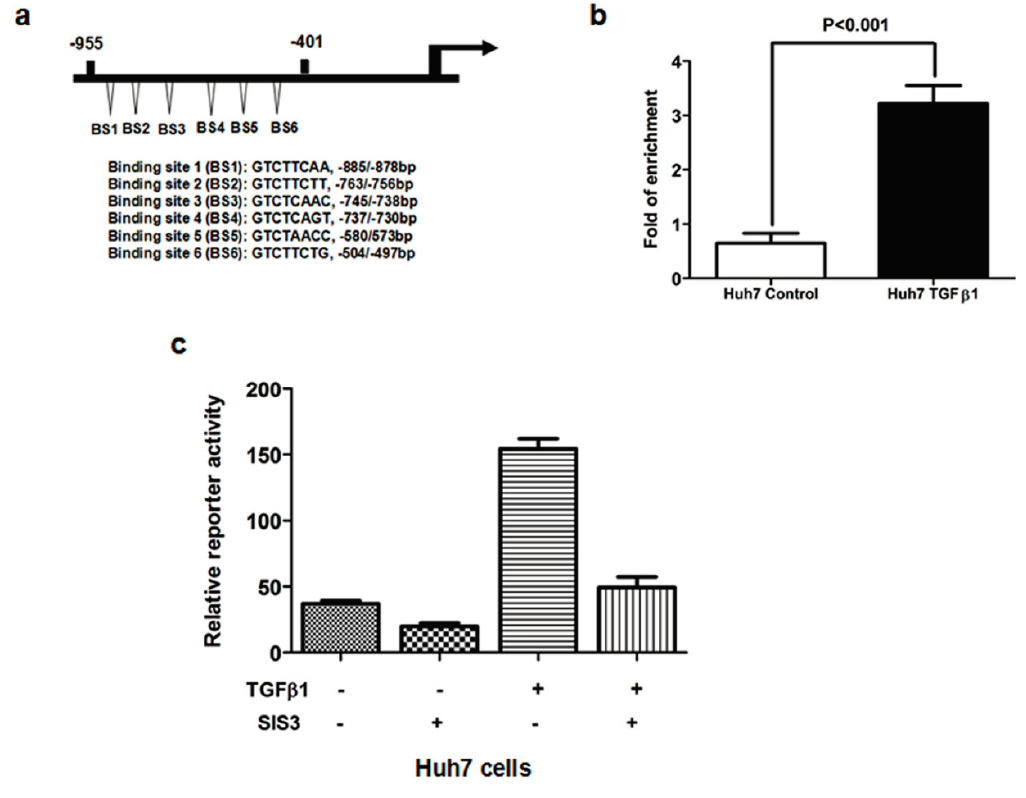
Figure 5. ( a ) Schematic diagram of the potential Smad binding sites in the promoter of MRC2 which shows there are six neighboring potential Smad binding sites in the − 955/ − 401 bp MRC2 promoter fragment; ( b ) With the help of ChIP assay, we obtained the DNA fragments bound with Smad protein in the nucleus of Huh7 cells. As assessed by PCR assay, TGF β 1 treatment increased significantly the occupancy of Smad protein in the MRC2 promoter; ( c ) The luciferase reporter assay showed that TGF β 1 treatment leaded to more MRC2 luciferase activity in Huh7 cells, which was abolished by the Smad3 inhibitor SIS3. These data strongly demonstrated that Smad3 was involved closely in the regulatory effect of TGF β 1 on MRC2